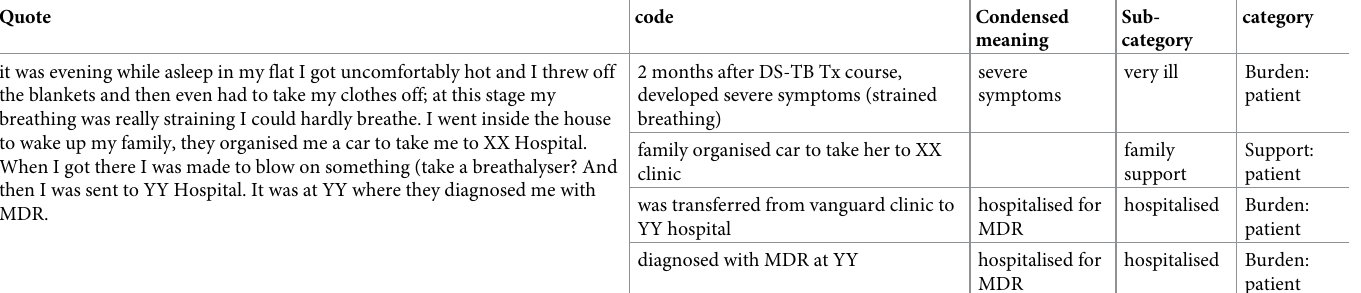
Table 1. Example of